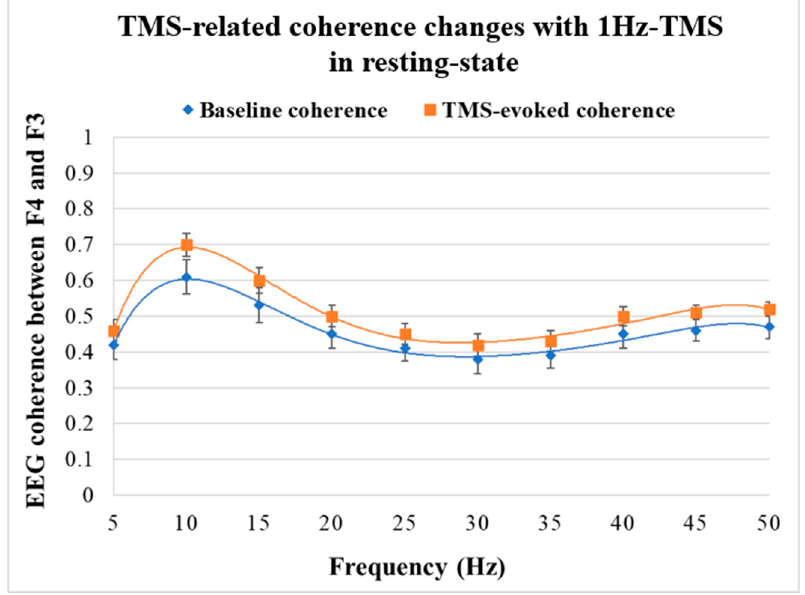
Figure 4. TMS-related coherence changes between F4 and F3 with 1Hz-TMS in resting-state. Figure 4 depicts the EEG coherence-frequency curves before and after 1Hz-TMS stim- ulation. In this experiment, TMS was applied to the right DLPFC (i.e., F4 electrode site) and the coherences between F4 and F3 electrodes was calculated.